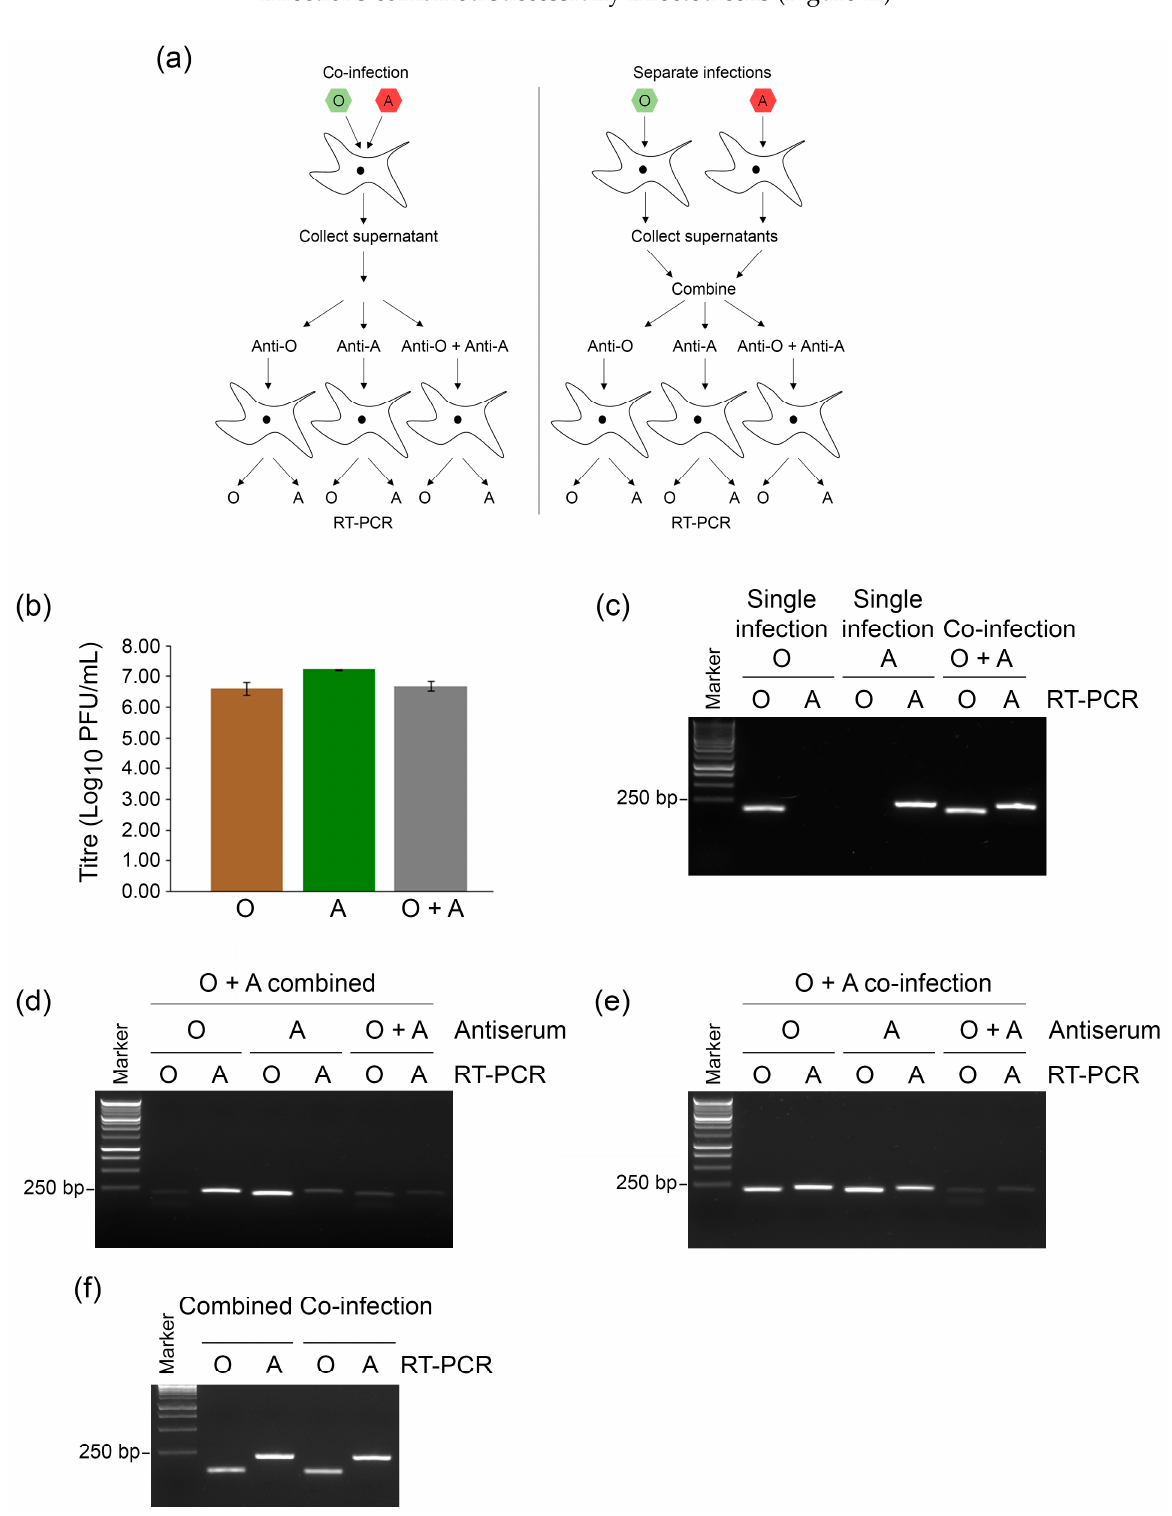
Figure 2. Trans-encapsidation between O and A serotype viruses enables escape from neutralizing antibodies. ( a ) Schematic diagram of the experimental workflow. ZZ-R 127 cells were either co-infected with FMDV-O and FMDV-A at an MOI of 1 per virus or infected with each virus separately for 16 h. Supernatants were collected, and those from the two separate infections were combined in a single tube. Aliquots of these samples were then incubated in the presence of anti-O, anti-A, or anti-O + anti-A antisera for 1 h prior to infection (MOI 0.05) of a fresh monolayer of ZZ-R 127 cells. After 16 h, RNA was prepared from the cells and RT-PCR was performed using primers specific for FMDV-O or FMDV-A. ( b ) Viruses obtained from the separate infections and the co-infection were